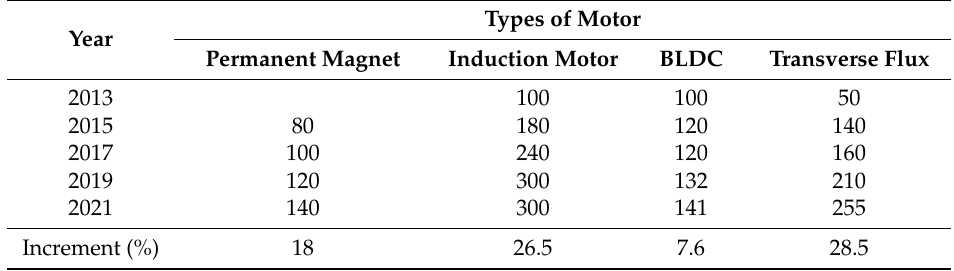
Table 5. Increment percentage of monstrous fan forecasting according to motor